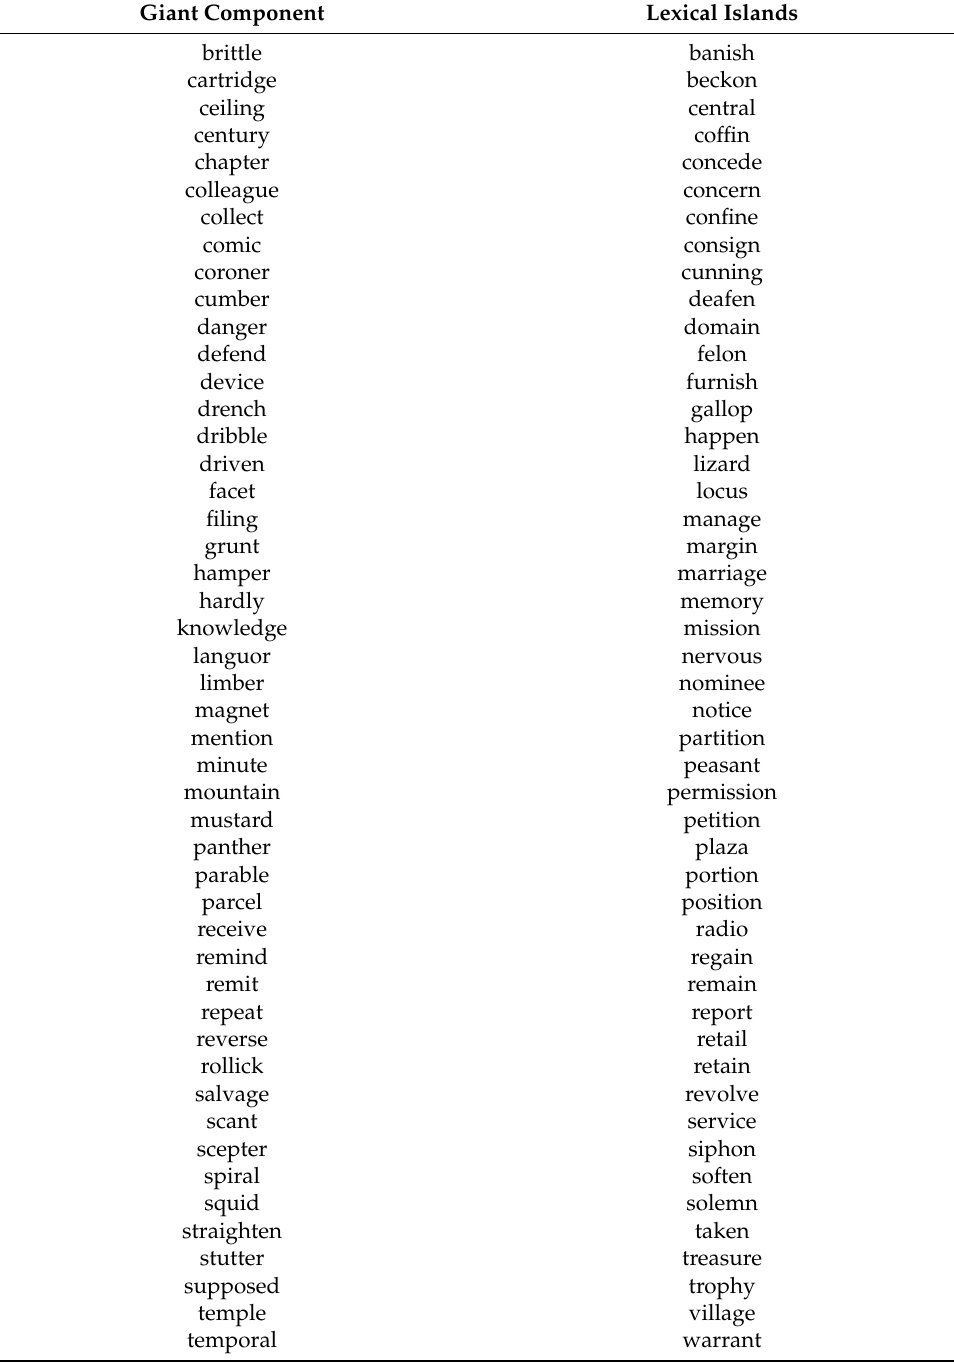
Table A2. Stimulus words from Siew and Vitevitch (2016) that were used in Simulation